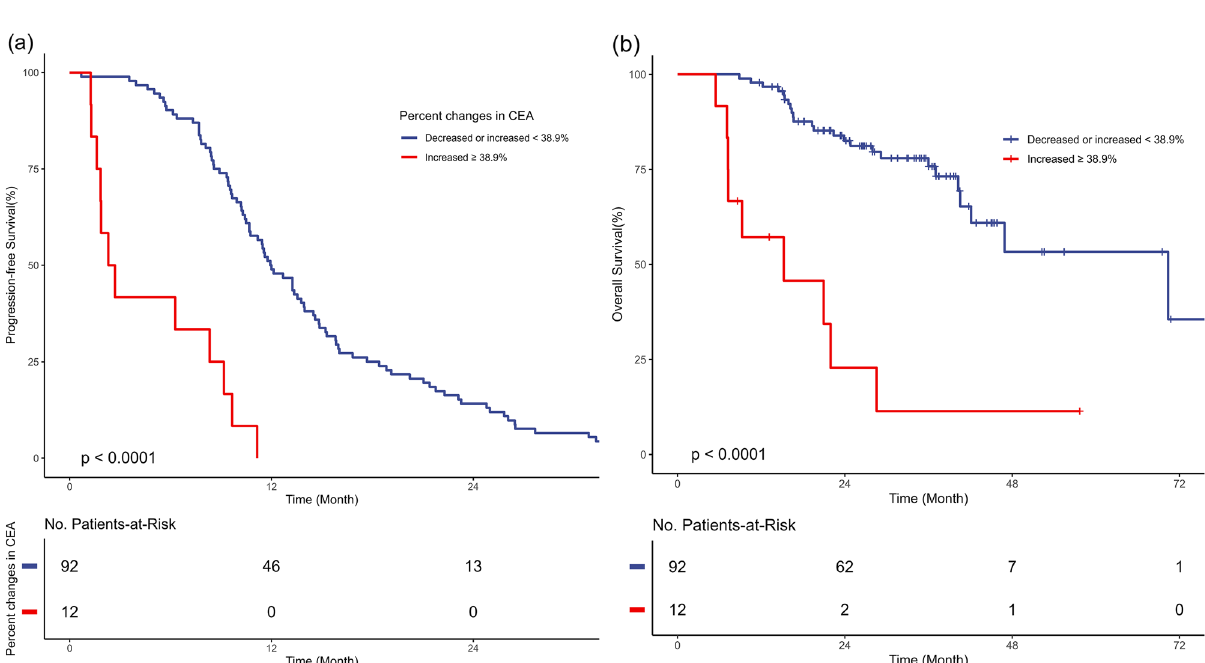
Figure 5. ( a ) Progression-free survival (PFS) and ( b ) overall survival (OS) according to the serum carcinoembryonic antigen (CEA) cut-off value for patients who received chemotherapy plus anti-epidermal growth factor receptor (EGFR) monoclonal antibody